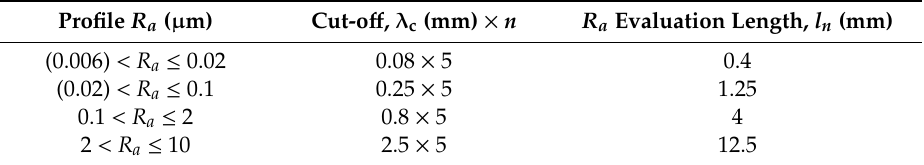
Table 4. Cut-o ff selection, λ c according to ISO 4288:1996